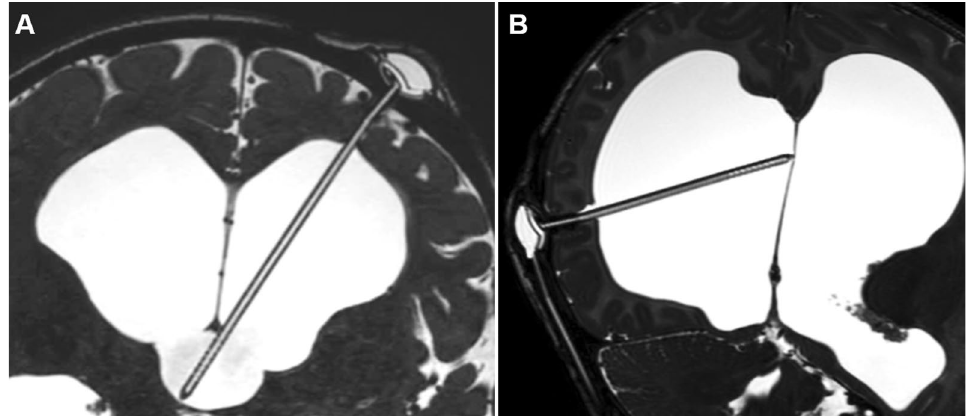
Fig. 2 Reconstructed 3D‑DRIVE in axial oblique plane ( A ) and coronal oblique plane ( B ) demonstrates luminal CSF signal throughout a patent cranial portion of